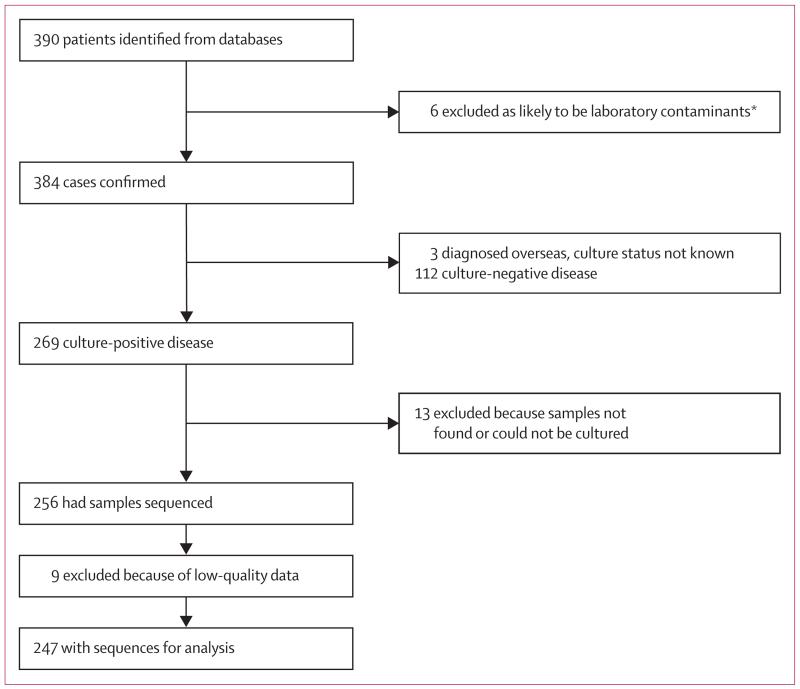
Flow chart of sample selection*Three laboratory contaminants were identified previously and three by use of whole-genome sequencing.